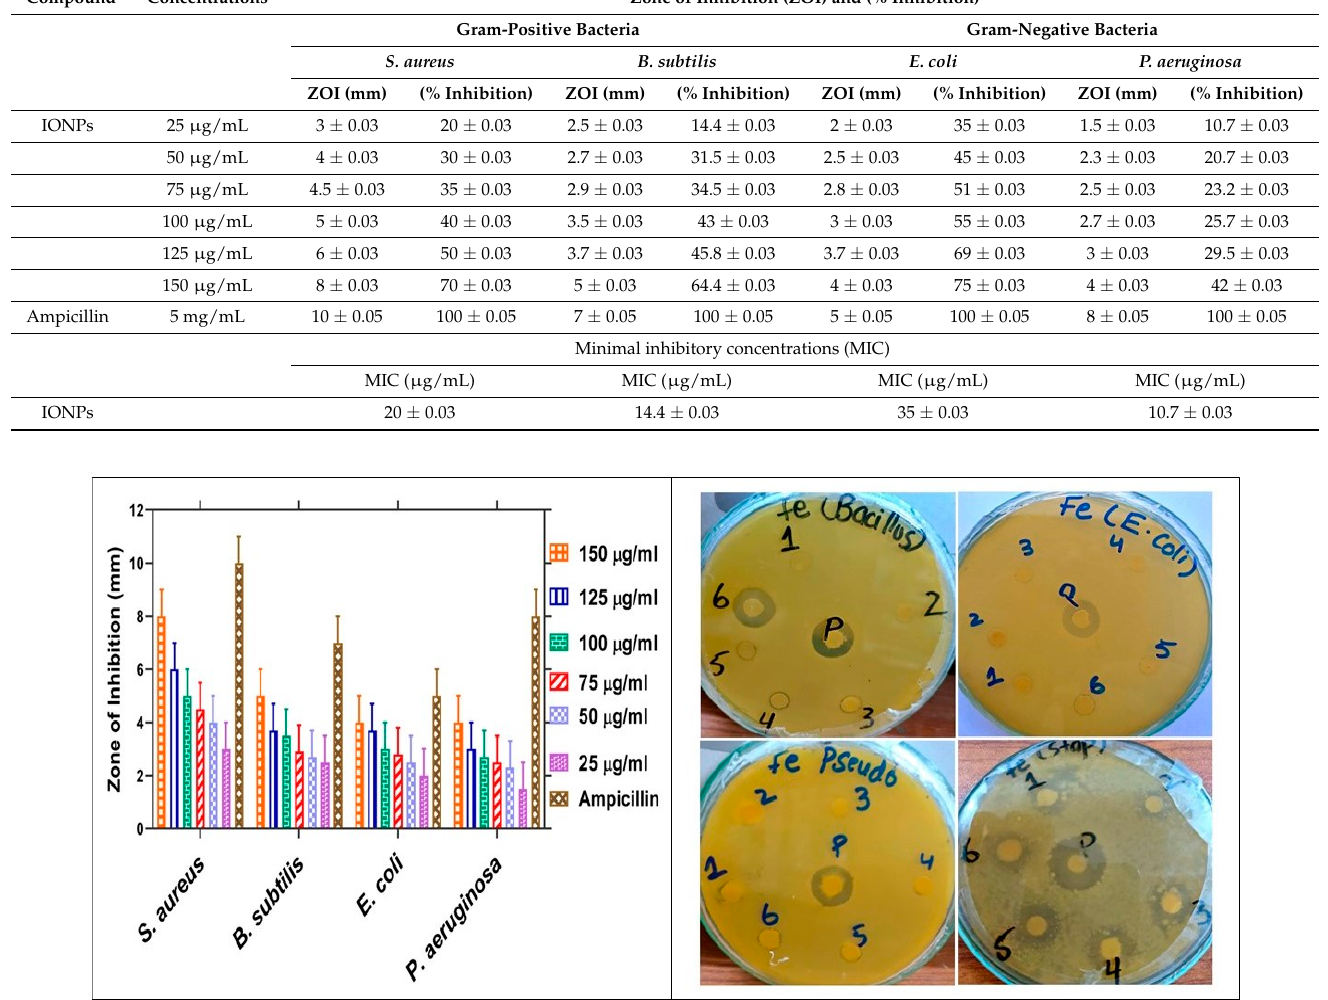
Figure 7. Antibacterial potential of Oscillatoria limnetica -mediated IONPs.